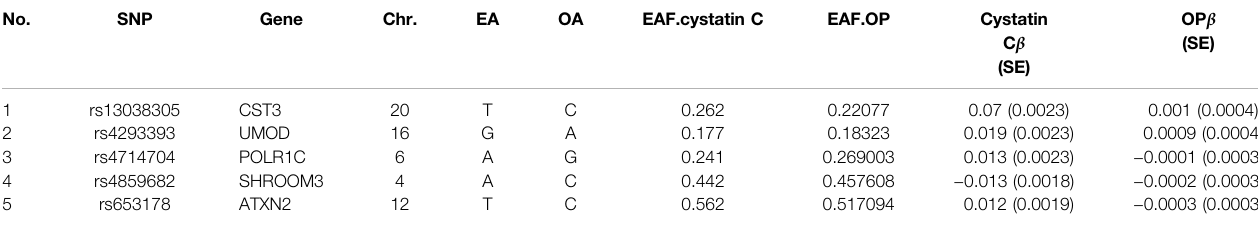
TABLE 1 | List of genetic instruments for cystatin C and log odds ratios of osteoporosis risk by each instrumental SNPs (GWAS signi fi cance with p < 5 × 10 − 8 and linkage disequilibrium. threshold with R 2 < 0.001). No.